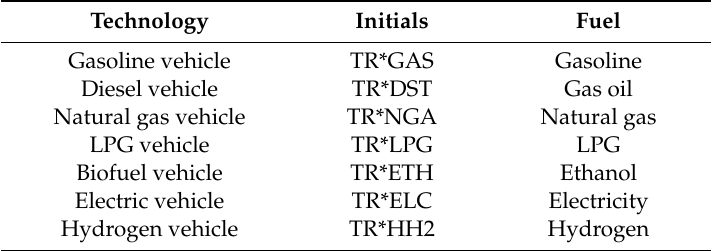
Table 3. Road transport base year technologies. Technology Initials